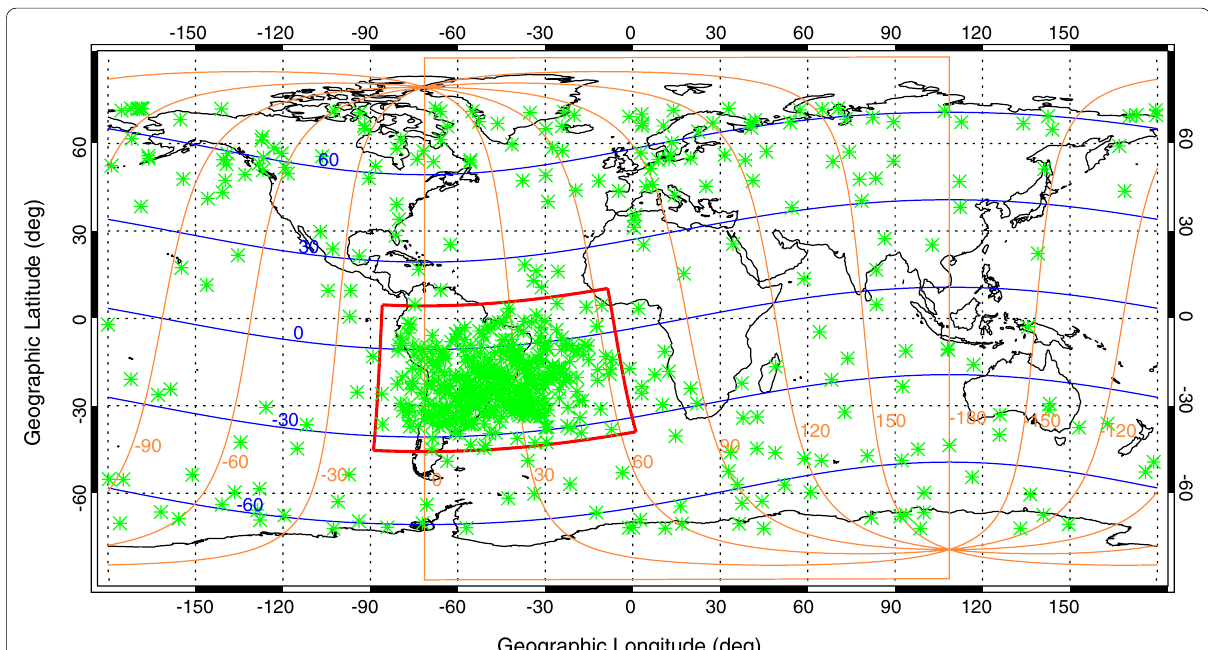
Fig. 1 Global distribution of the FS3 anomalies. The vertical and horizontal black dash lines represent various geographic longitudes and latitudes, respectively. The blue curves represent the magnetic latitudes, and the orange curves represent the magnetic longitudes. The red trapezoid marks the SAA region. The green asterisks mark the locations where the FS3 anomalies